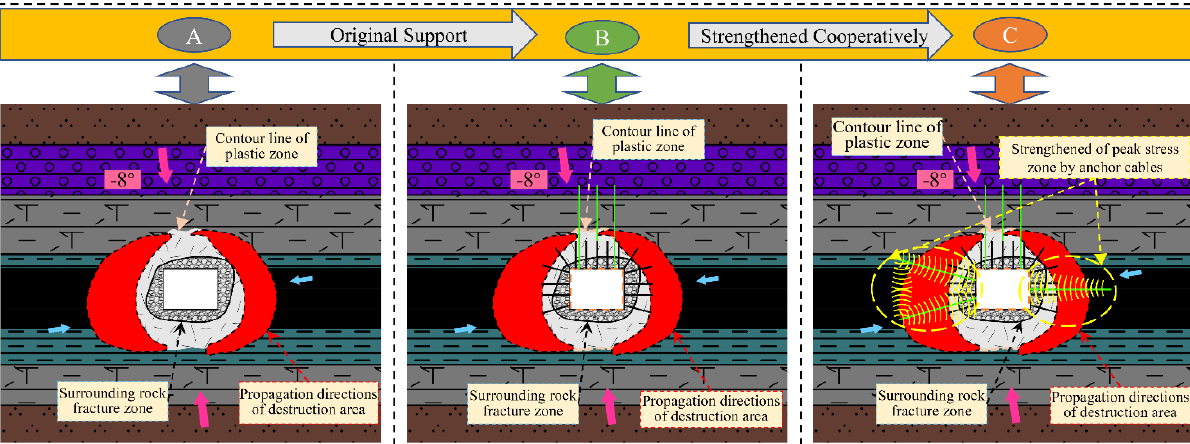
Figure 17. The support reinforcement principle of the No.3 coal seam main return-air roadway. ( A ) No support. ( B ) Original support. ( C ) Strengthen support.